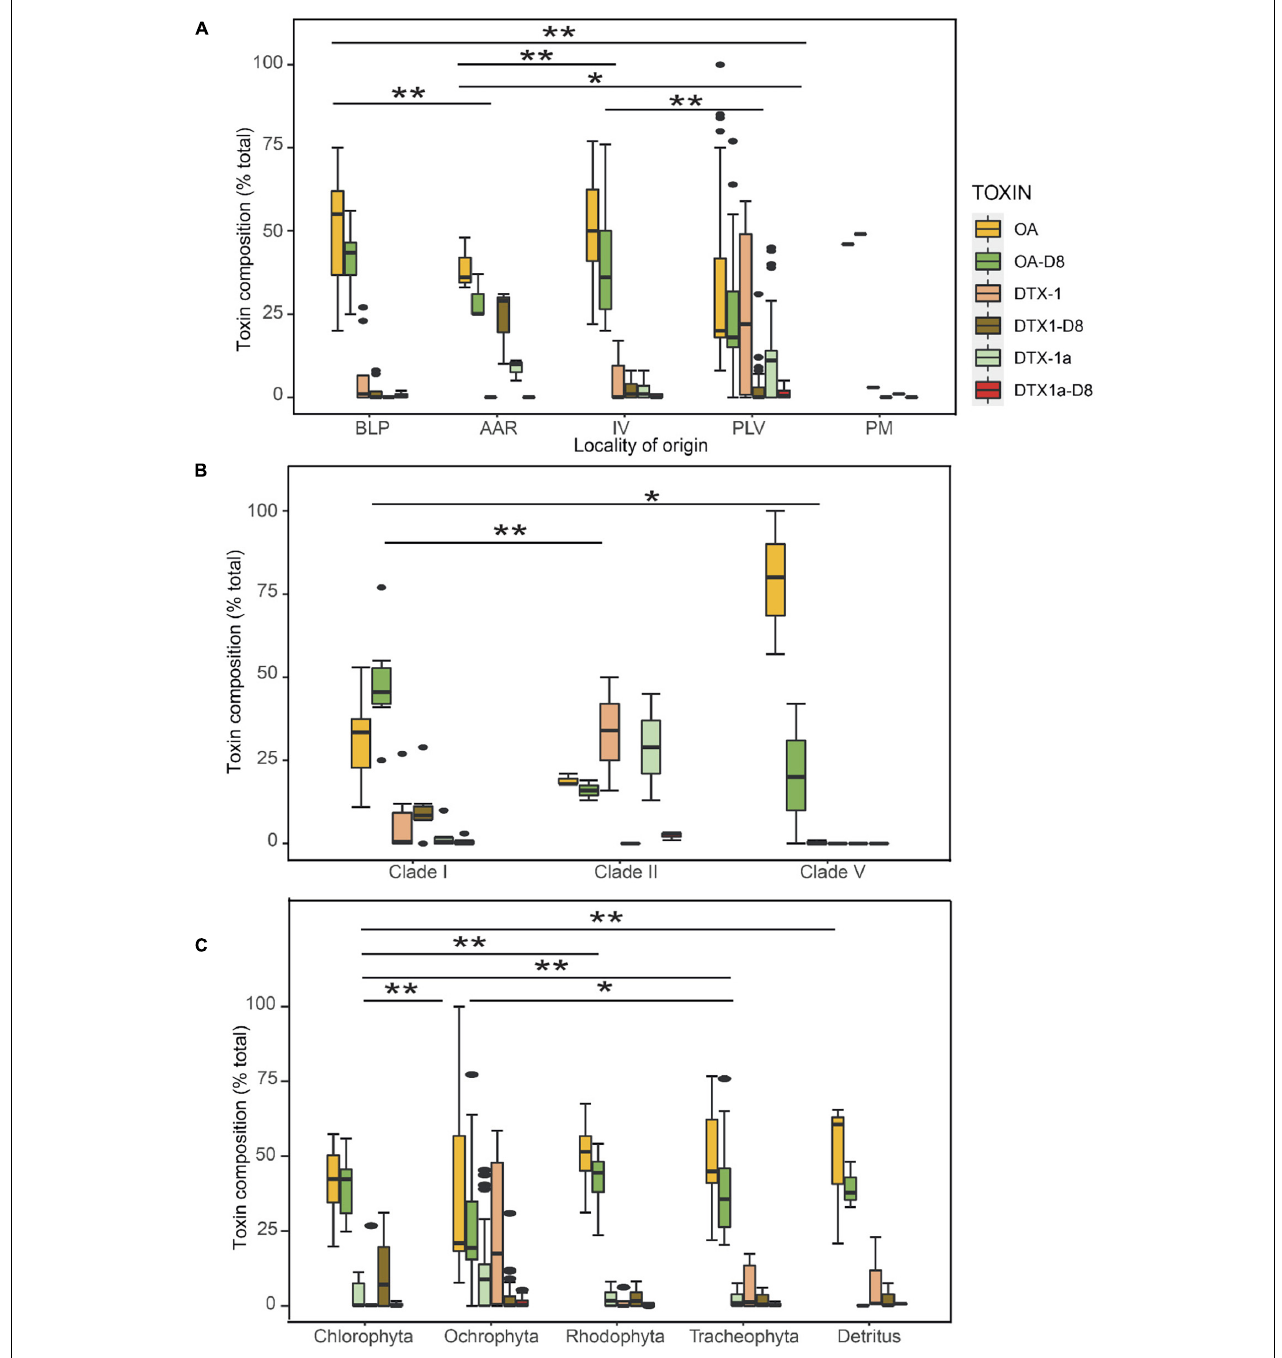
FIGURE 7 | Boxplot of Prorocentrum isolates according to relative toxin composition (% total) ( n = 67) in different groups. (A) Locality of origin; (B) Clade, (C) Substrate type. Group differences in toxin composition were tested with PERMANOVA (999 Permutations); asterisk indicates significant difference between groups based on pseudo-F-statistic (** < 0.01; * < 0.05) between individual